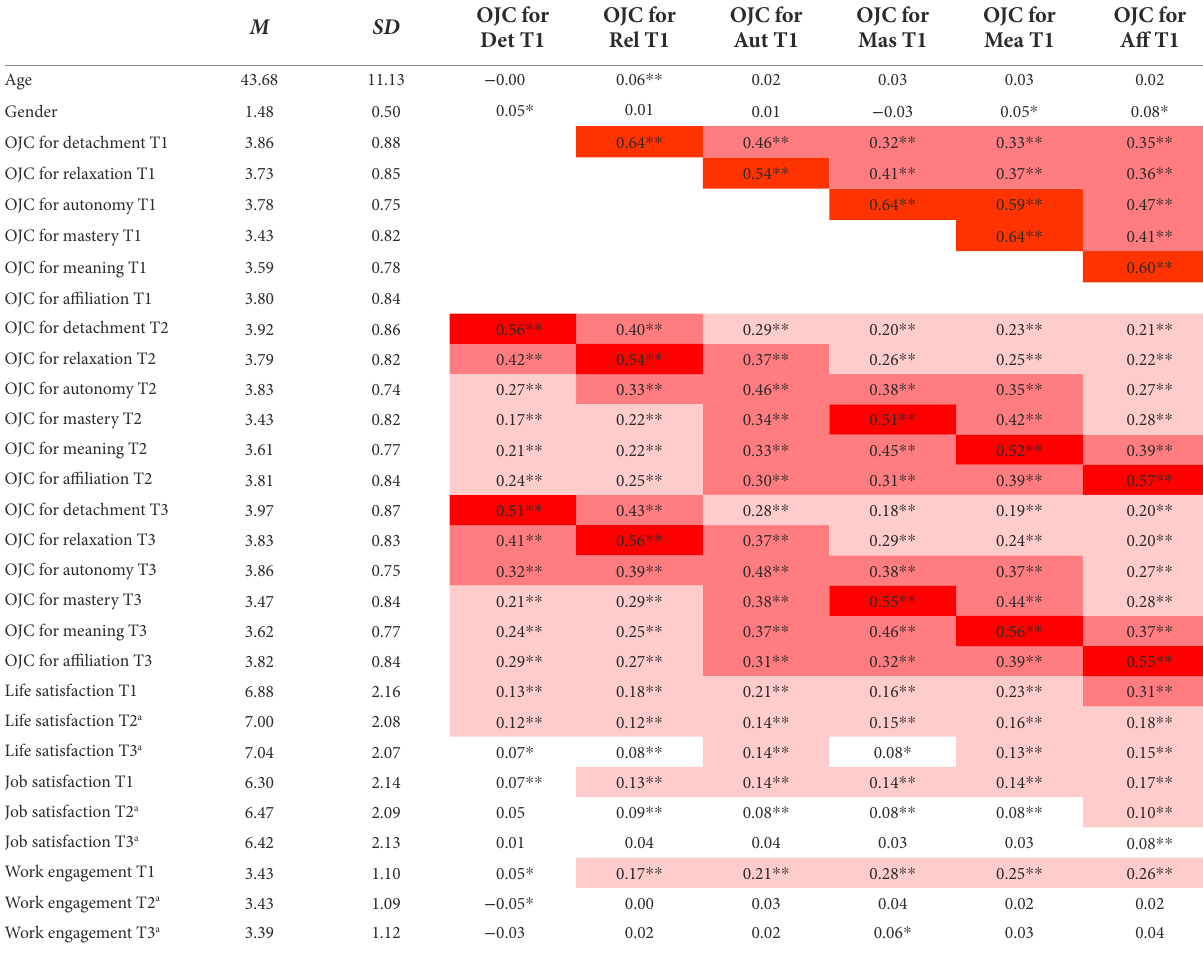
TABLE 4 Zero-order (Cross-sectional and Inter-scale) correlations and partial correlations of the OJC dimensions, Study 2. M